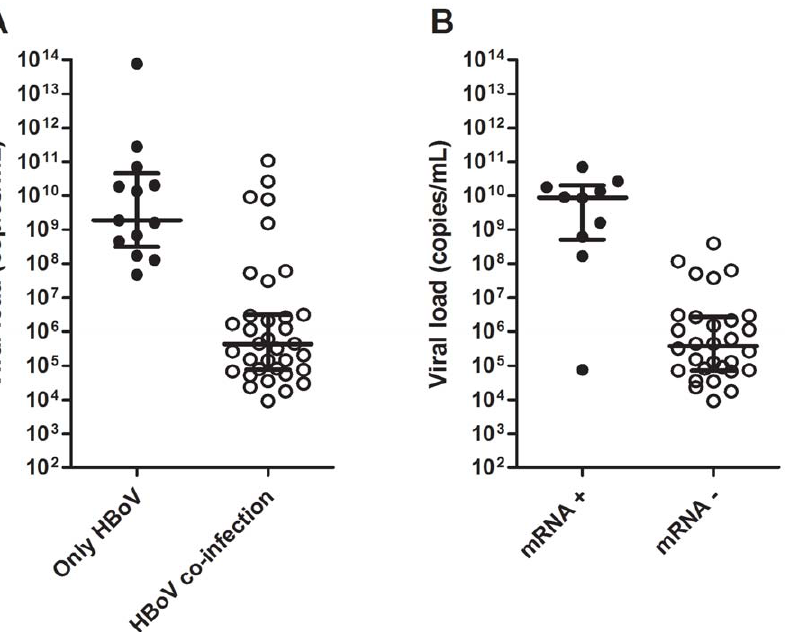
Figure 2. Viral loads of HBoV (copies of genomic DNA/mL) in NPAs by qPCR. A. HBoV viral loads in NPAs from patients with HBoV as single agent (black circles), and with simultaneous detection of other respiratory viruses (white circles). B. HBoV viral loads in NPAs from patients with (black circles) and without (white circles) detectable shedding of HBoV VP1 mRNA by real time PCR.